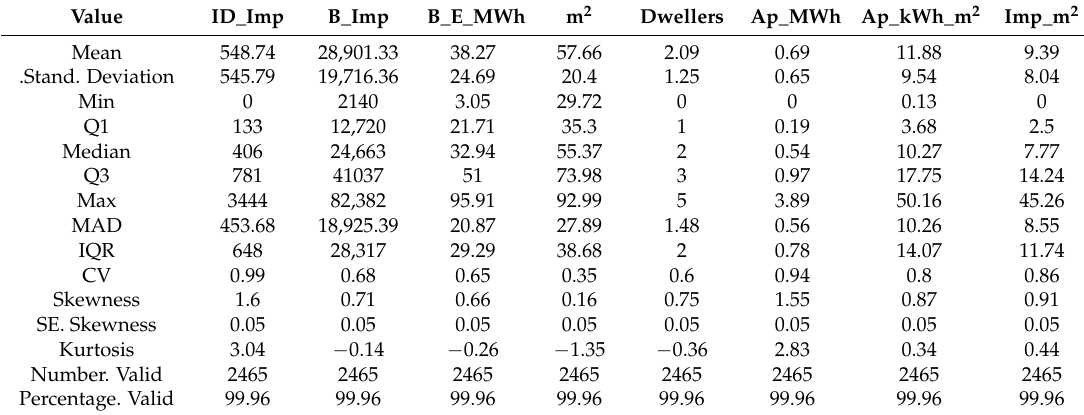
Table 4. Summary statistic of quantitative data in the analysed